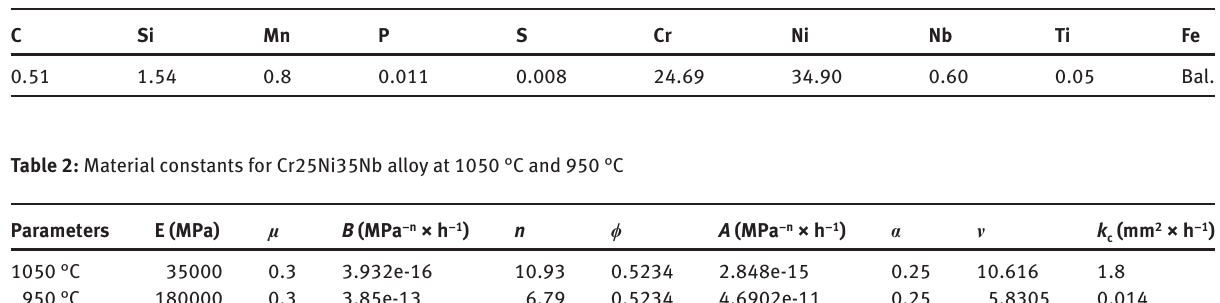
Table 1: Chemical composition of Cr25Ni35Nb alloy (wt.%)